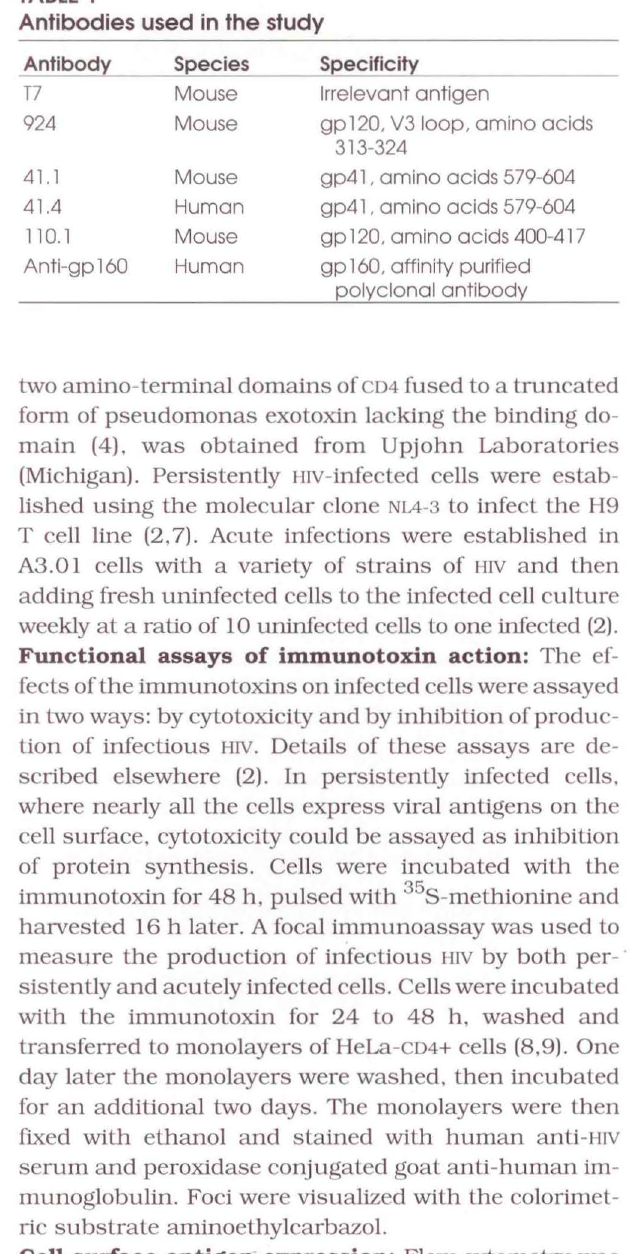
Antibodies used in the